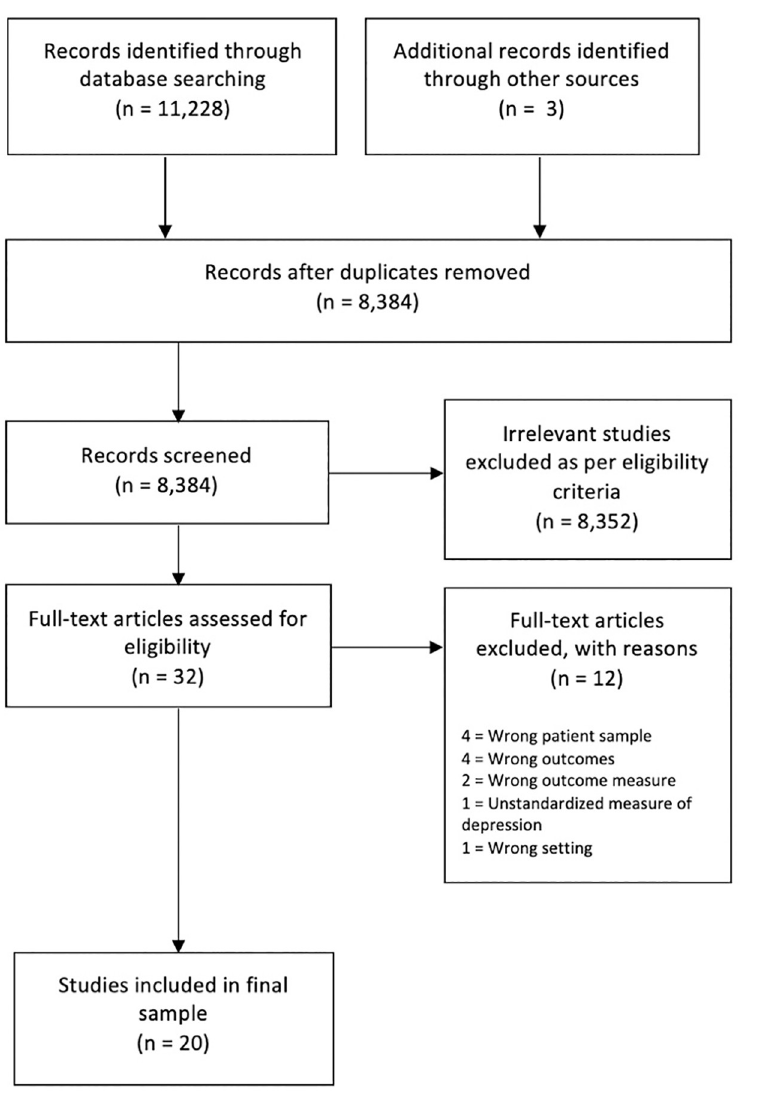
Fig 1. PRISMA inclusion